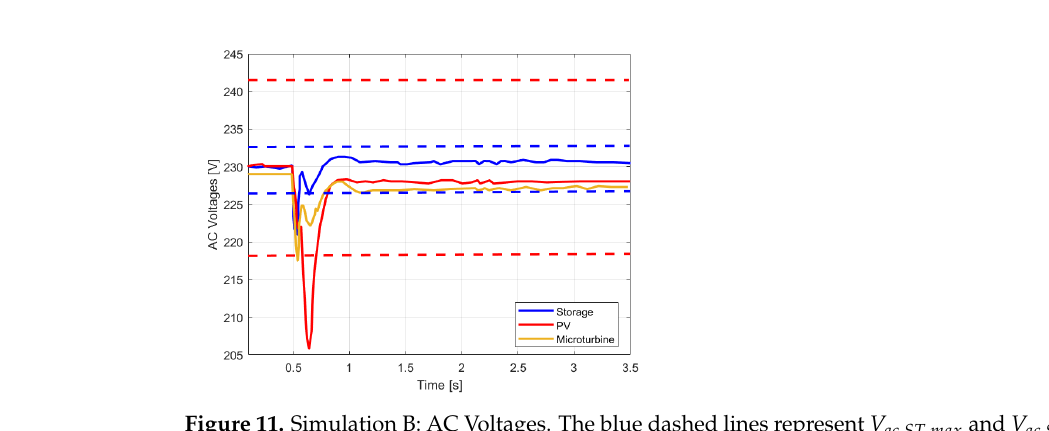
Figure 11. Simulation B: AC Voltages. The blue dashed lines represent V ac , ST , max and V ac , ST , min , while the red dashed lines represent V ac , PV , max and V ac , PV , min .